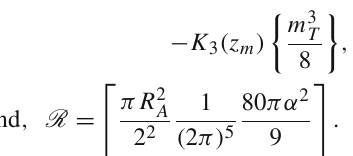
(Eq. 44) for different jet-quenching T